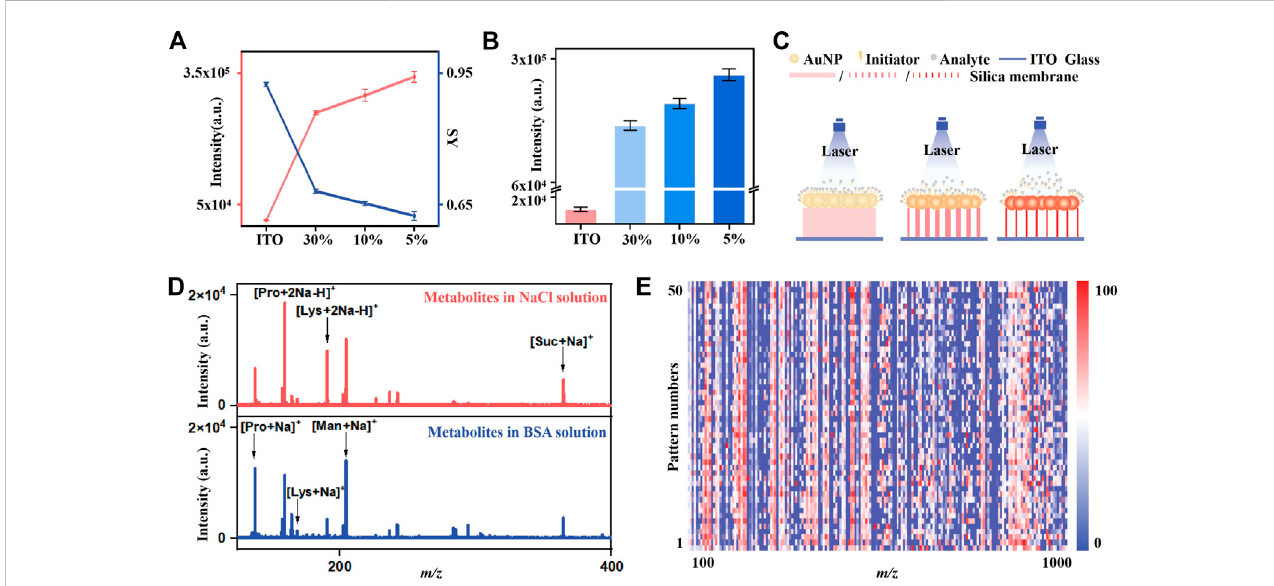
FIGURE 3 The determination of ion-desorption ef fi ciency and internal energy transfer in the LDI process of chips with different porosity silica membranes: (A) The totalintensity ofBPions (redline) andSYof parentions (blue line)desorbed from chipswith differentporosity silicamembranes. (B) The intensity of parentBP ions desorbed from chips with different porosity silica membranes (C) Schematic illustration of the effect of silica membranes with different porosity on LDI performance. (D) The mass spectra ofsmall metabolites mixture in0.5 MNaClsolution(red) and in5 mg/mLBSAsolution (blue) onIGMSMchip (E) Heat map of 50 independent metabolic patterns for one KS patient urine sample within m/z range from 100 to 1,000 through data